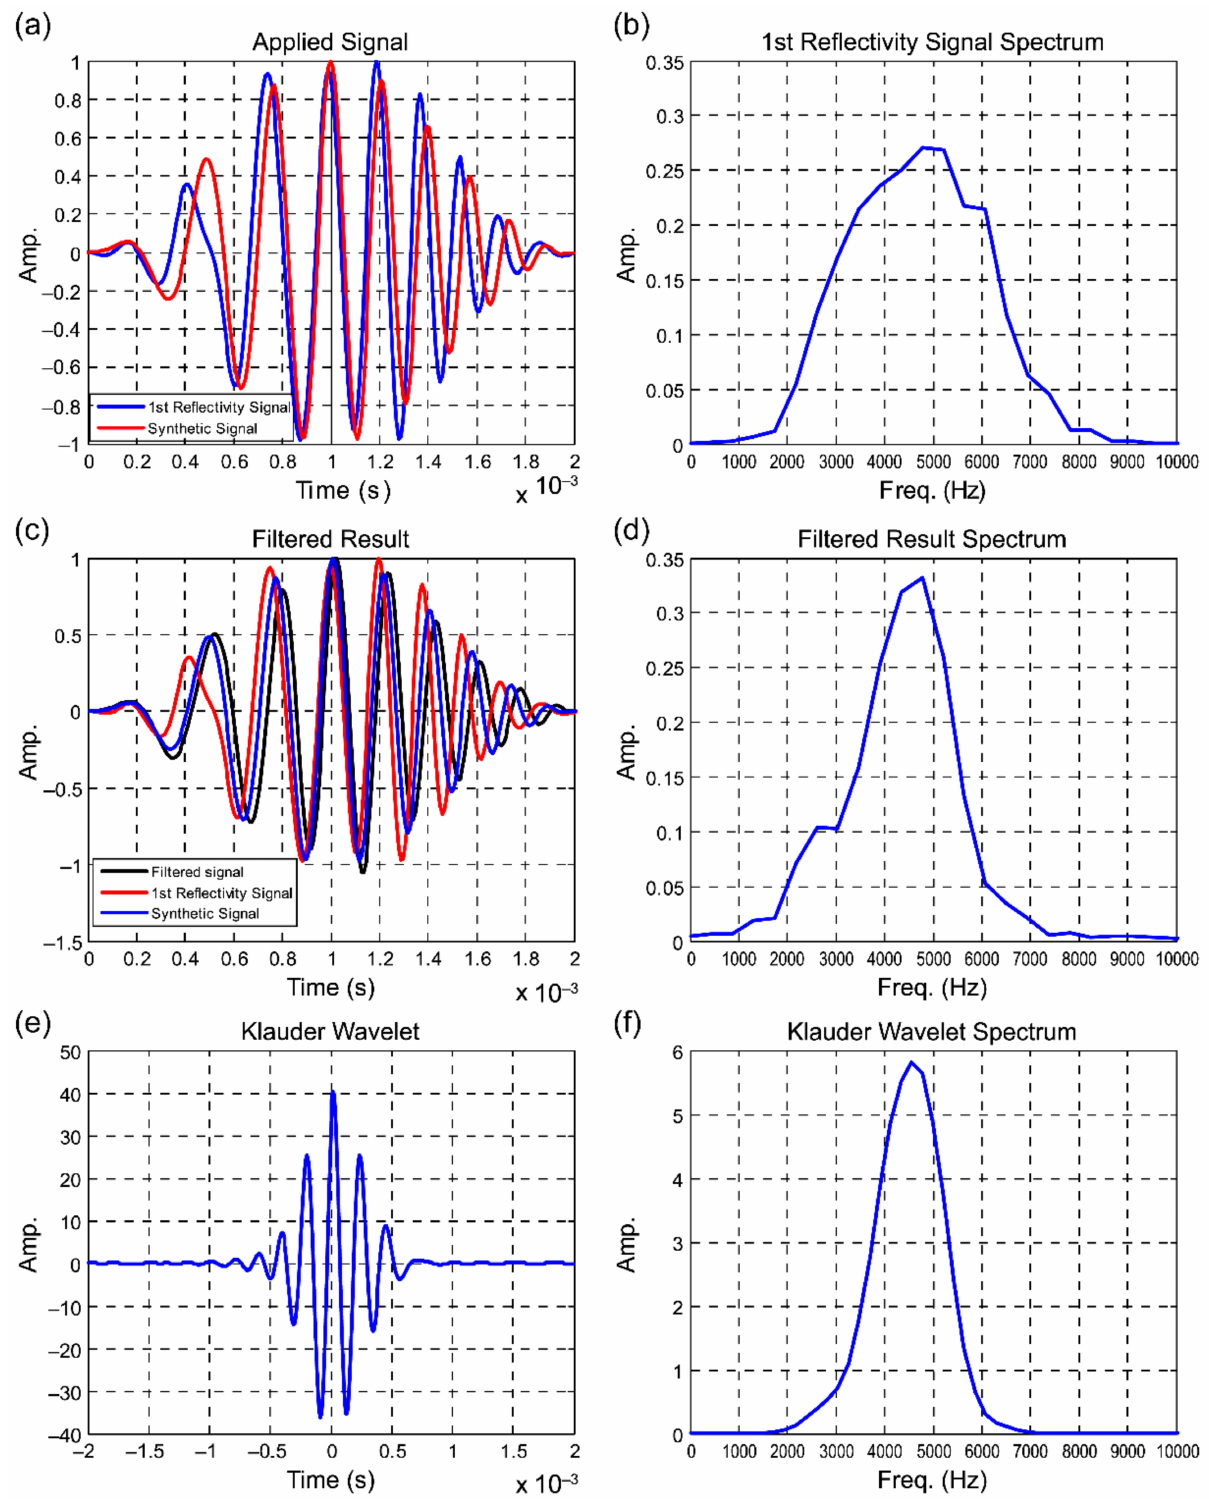
Figure 8. Based on the synthetic signal, the filtered signal was obtained through the combination with the first reflectivity signal. ( a ) Synthetic source signal and first reflection signal extracted from raw data. ( b ) Amplitude spectrum of ( a ). ( c ) Adaptive filtered source signal obtained from ( a ). ( d ) Amplitude spectrum of ( c ). ( e ) Wavelet obtained through the correlation of the first reflection signal extracted from raw data and adaptive filtered source signal. ( f ) Amplitude spectrum of ( e